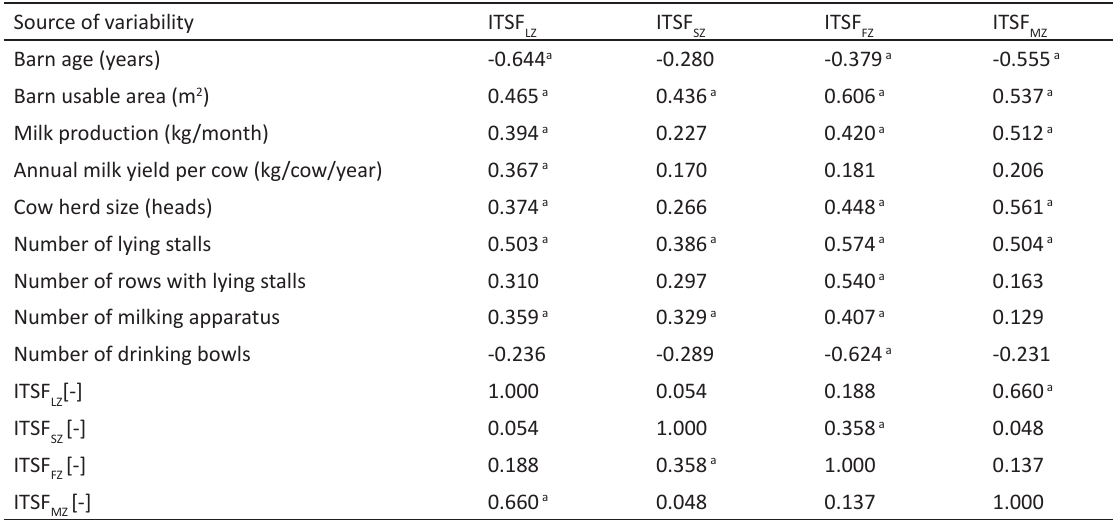
Table 4. Correlation coefficients of the ITSF values and the variables collected in the 38 investigated dairy farms Source of variability ITSF